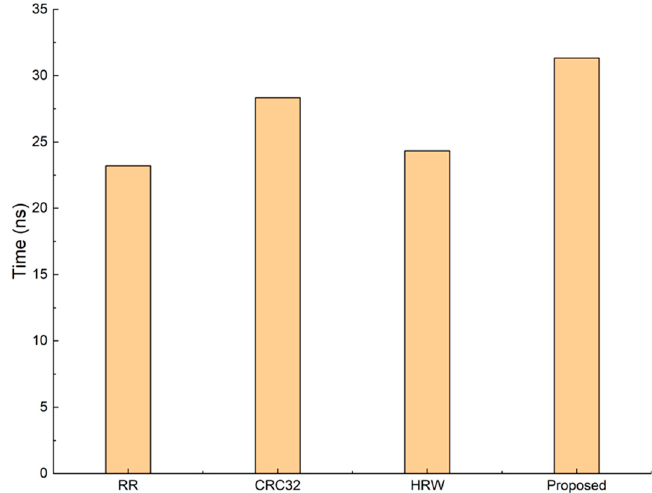
Figure 6. Average time spending on distributing a packet of different methods.